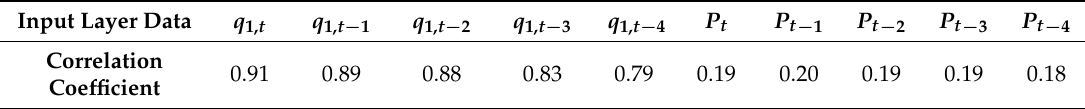
Table 1. Correlation coefficients between input layer data and the output